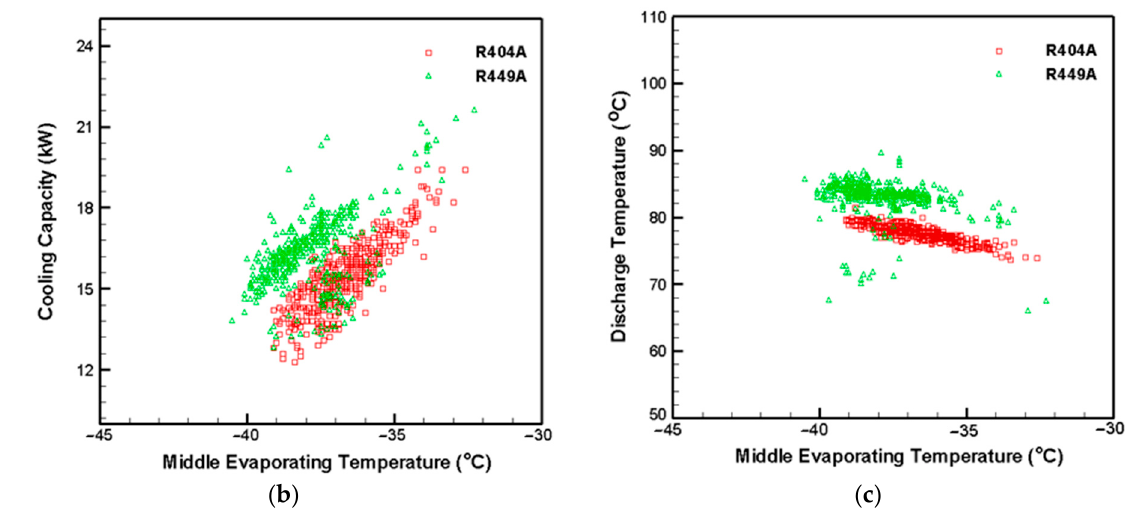
Figure 7. Experimental values for ( a ) COP, ( b ) cooling capacity, and ( c ) discharge temperature of the supermarket refrigeration system at LT application.